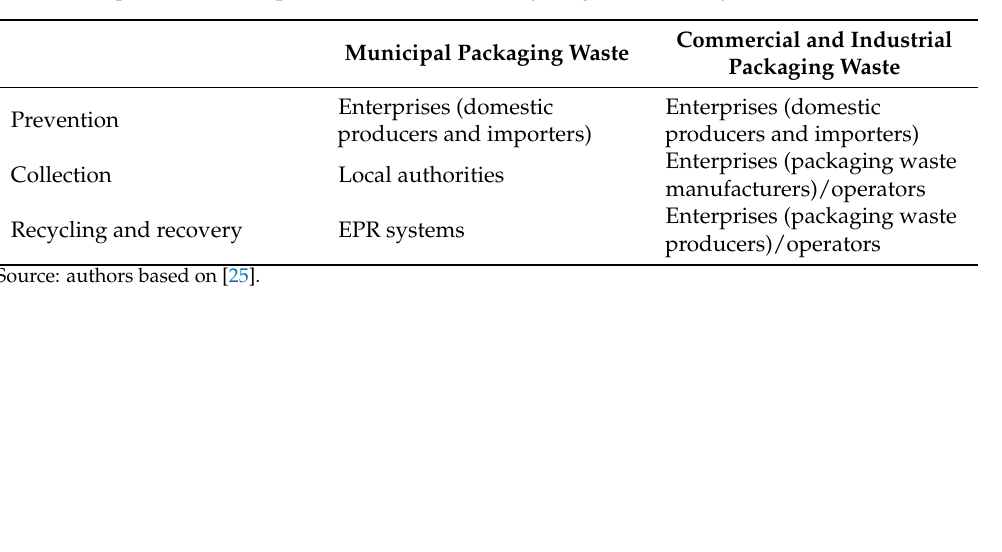
Table 2. Responsibilities for prevention, collection, recycling, and recovery in